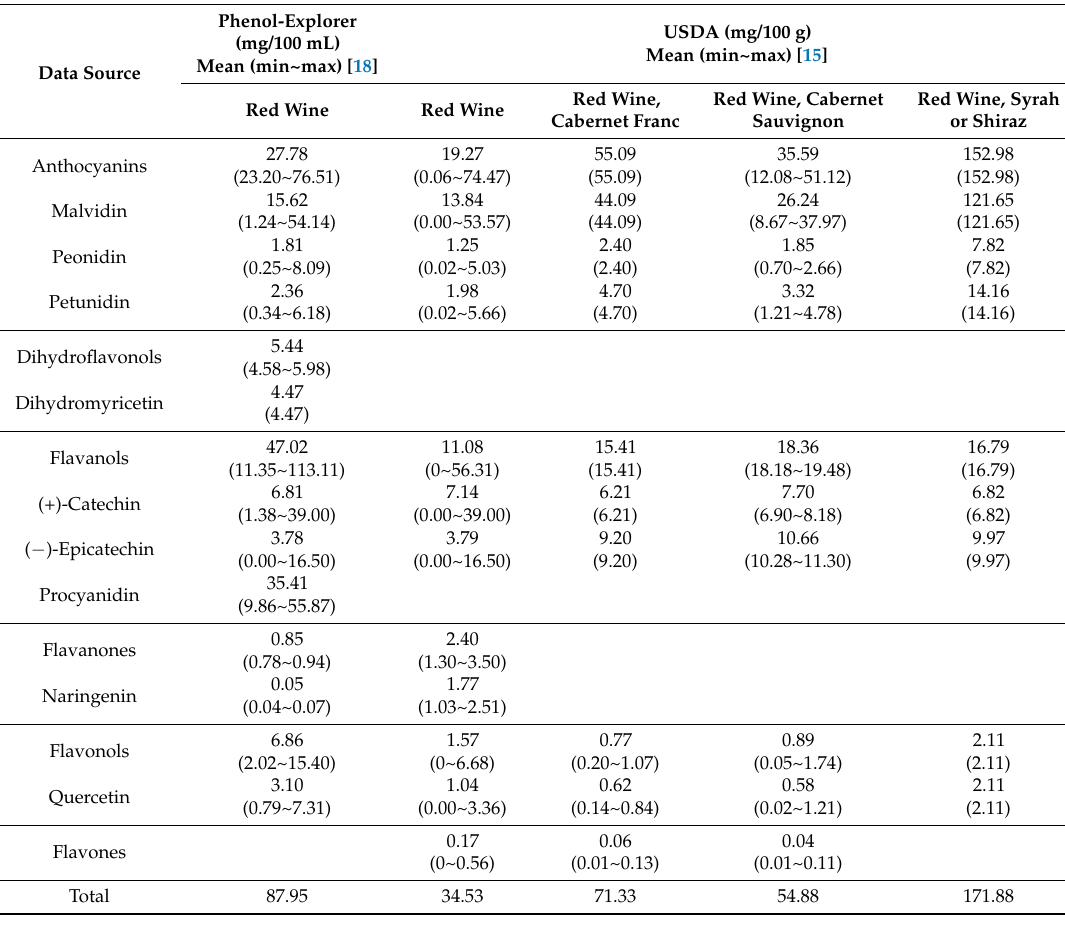
Table 1. Contents of flavonoid family and major flavonoids in red